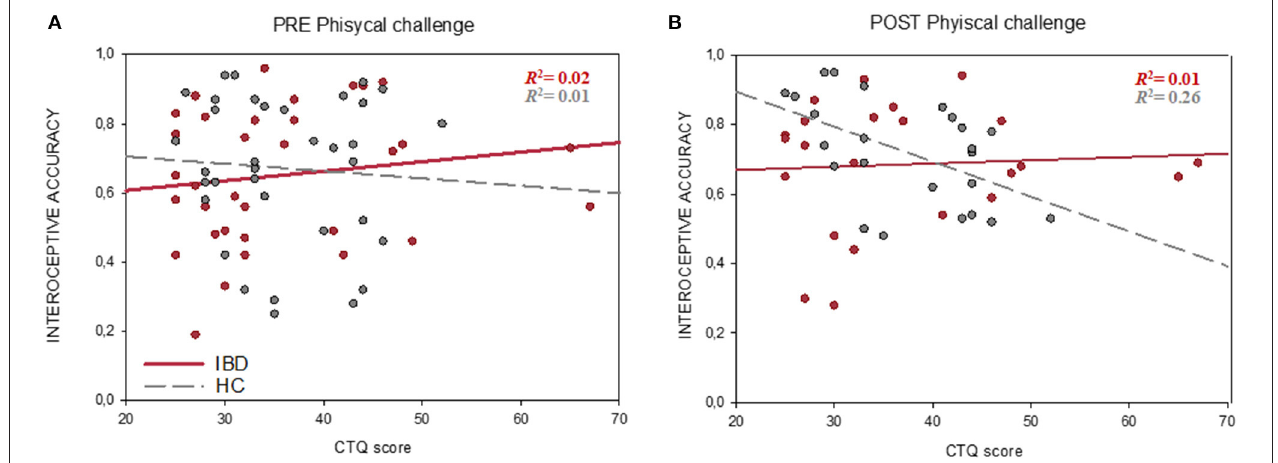
FIGURE 4 | Associations between Interoceptive accuracy (HBT) and childhood traumatization (CTQ score) before (A) and after the physical challenge (B) . In contrast to the IBD group (red line), HCs (gray dashed line) showed a significant negative correlation between interoceptive accuracy and CTQ scores after the physical challenge. the physical challenge was implemented only in a subsample of 48 participants. CTQ, childhood trauma questionnaire; HC, healthy controls group; IBD, inflammatory bowel diseases group.